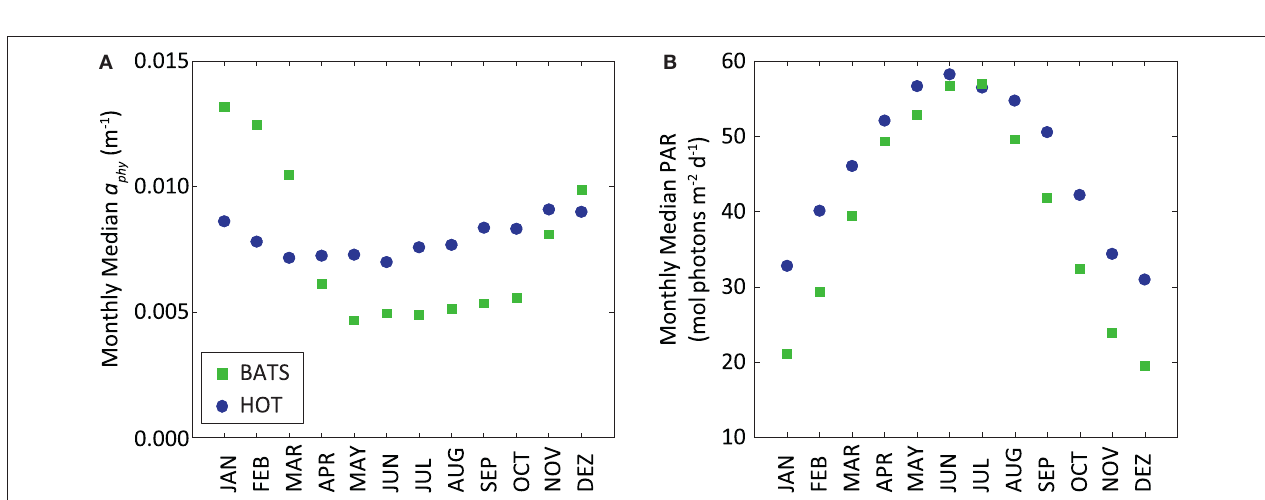
FIGURE 10 | (A) Monthly median of MODIS-Aqua a phy (m − 1 ) and (B) monthly median of MODIS-Aqua PAR (mol photons m − 2 d − 1 ) at surface. In both graphs stations HOT (blue circles) and BATS (green squares) are displayed together.